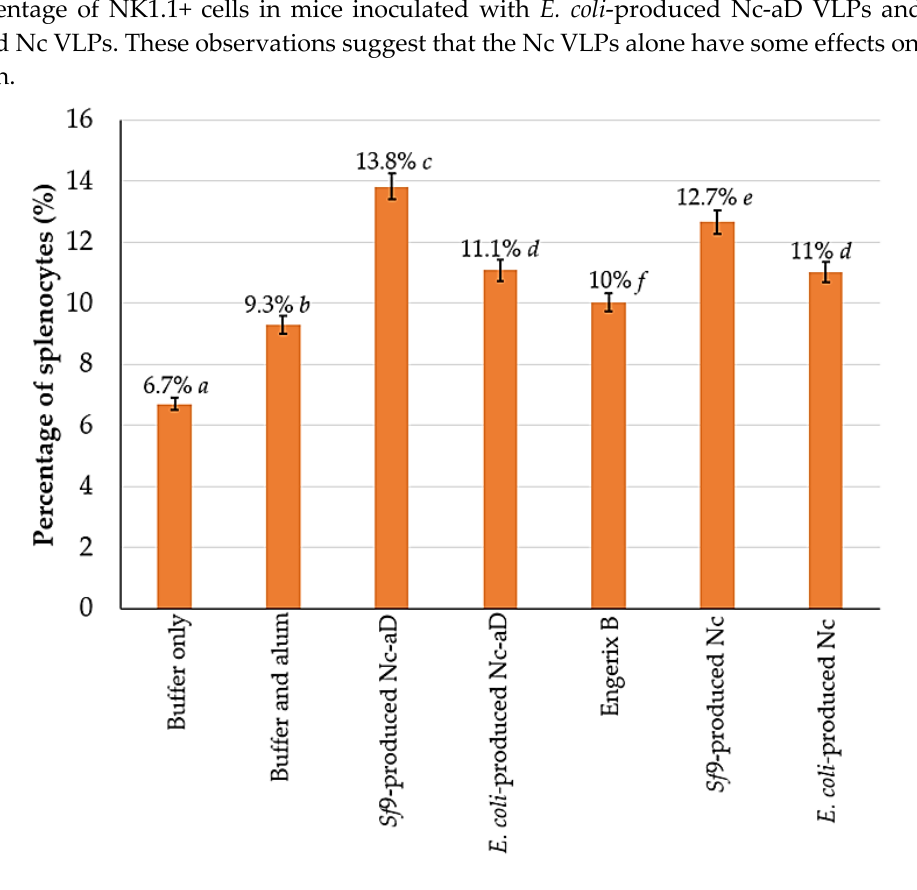
Figure 4. Frequency of NK1.1 + mouse splenocytes. Splenocytes from mice sacrificed on day 63 were probed with the anti-NK1.1 monoclonal antibody labelled with FITC. The percentage values shown above represent the percentage of NK1.1 + splenocytes from the 1 × 10 5 probed cells analysed with a flow cytometer. The error bars indicate the standard deviation (SD) of triplicate measurements. The letters (a, b, c, d, e, f) shown above the bars represent the statistical significance of the measurements. Percentage values which are marked by different letters are significantly different ( p < 0.001), and those marked by the same letters are not significantly